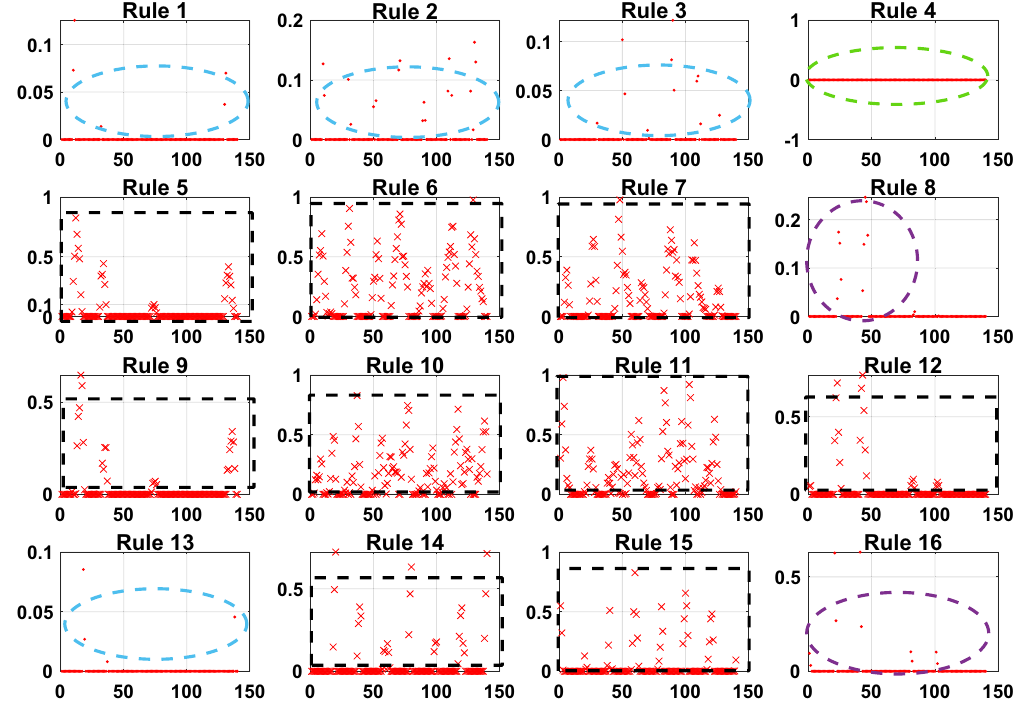
Figure 14. Analysis of Sub-BRB3 rule activation weights (x-axis represents test data, y-axis represents activation weights).